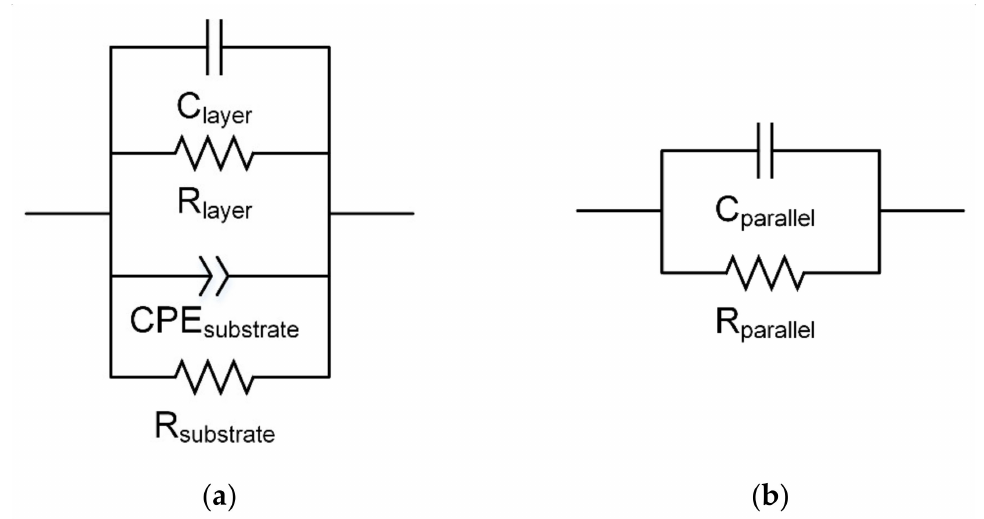
Figure 9. Electric equivalent circuits: ( a ) model of β -Ga 2 O 3 epitaxial layer grown on Au interdigitated electrodes on Al 2 O 3 substrate; ( b ) parallel RC connection used to analyze changes of the capacitance of the measured system in the frequency range below 10